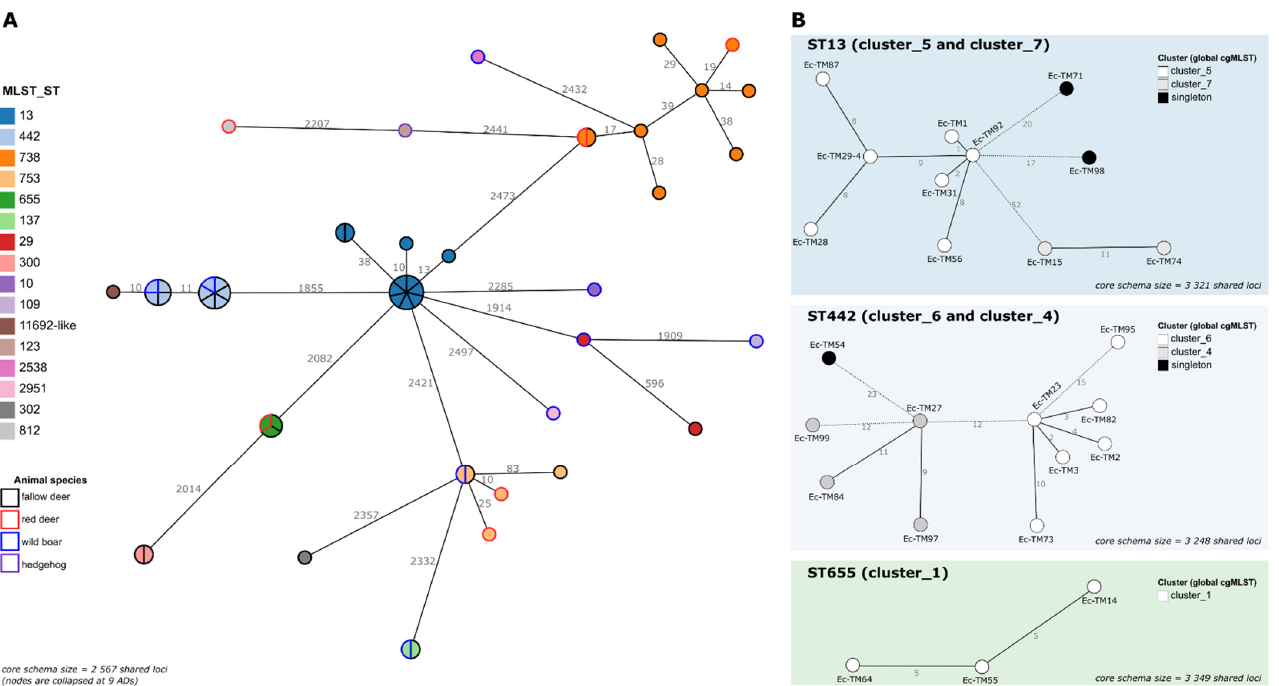
Figure 1. The cgMLST analysis of pathogenic E. coli . ( A ) The global Minimum Spanning Tree (MST) was reconstructed, based on the core-genome of the 52 isolates (i.e., a sub-schema of the original 7601-loci wgMLST schema comprising loci called in all samples). Each circle (node) represents a single isolate or a cluster of isolates linked by ≤ 9 ADs (corresponding to the 0.34% threshold applied for cluster investigation). Each division in a node corresponds to a single isolate. Node colors reflect the ST (inner color) and the animal species (outer line color) of each isolate. Lines connect nodes with ADs above the applied threshold, with the numbers representing the ADs between nodes. ( B ) For each ST of interest (details in Table 3), an MST was constructed, based on a dynamic cgMLST analysis, enrolling a maximized ST-specific core-genome schema (i.e., a sub-schema comprising the loci called in all the isolates of the same ST). Only the MSTs corresponding to STs harboring clusters with >2 isolates are presented (see details for the others in Table 3). Each circle (node) represents a unique allelic profile, with colors reflecting the genetic cluster to which the isolate belonged in the global cgMLST analysis. Straight and dotted lines reflect nodes linked with the ADs below/equal, and above, the 0.34% threshold applied for cluster investigation, respectively. The numbers in the connecting lines represent the ADs between isolates. All MSTs were constructed using the GrapeTree MSTreeV2 algorithm implemented in the ReporTree pipeline (https://github.com/insapathogenomics/ReporTree), using the chewieNS schema